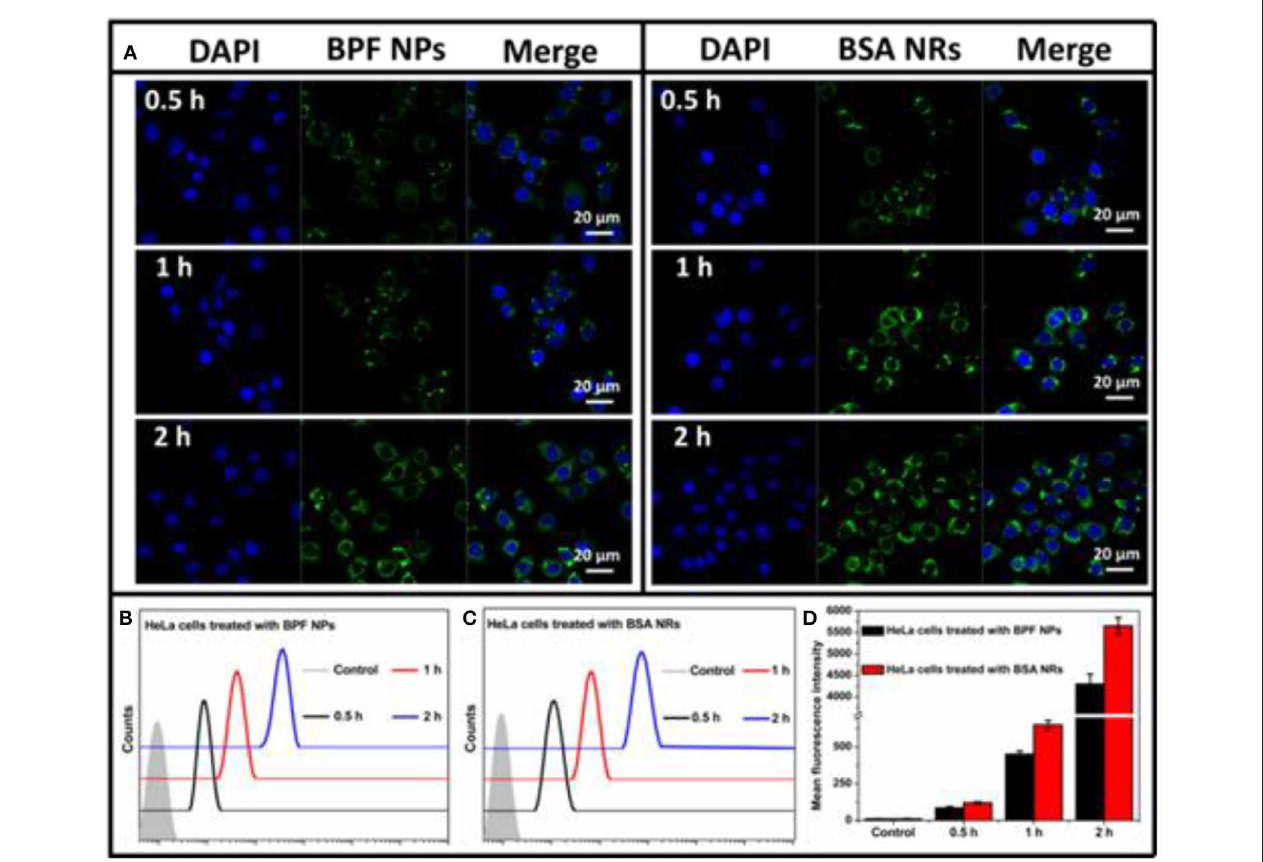
FIGURE 4 | (A) CLSM images of HeLa cells incubated with BPF NPs or BSA NRs for 0.5, 1, and 2h at 37 ◦ C, respectively. Cells are viewed in the blue channel for DAPI, the green channel for BDP. Scale bars represent 20 µ m in all images. (B) Flow cytometry histograms of HeLa cells treated with BPF NPs and without treatment (control) for different hours, respectively. (C) Flow cytometry histograms of HeLa cells treated with BSA NRs and without treatment (control) for different hours, respectively. (D) Quantitative analysis of (B,C) . The data are presented as the mean values ± standard deviation, n =